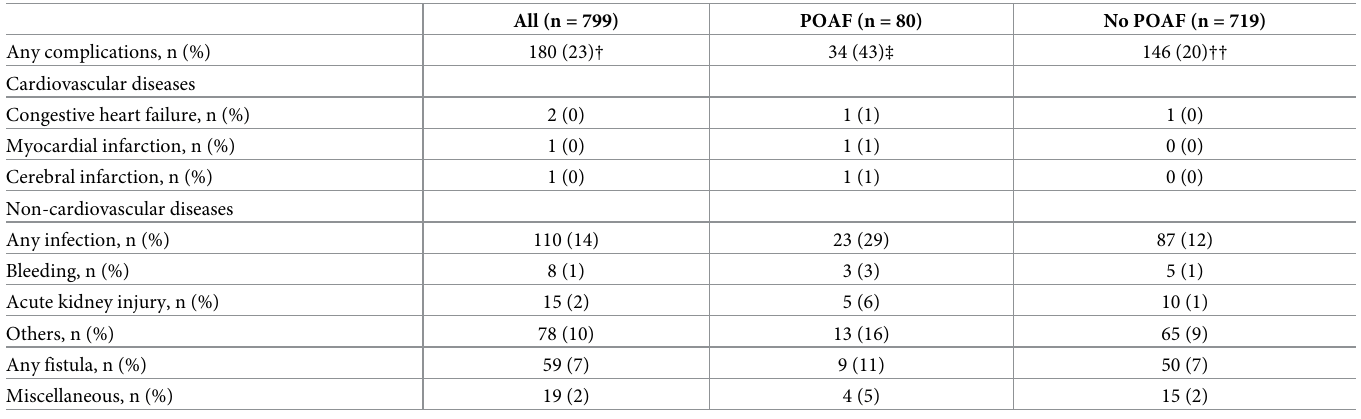
Table 2. Details of